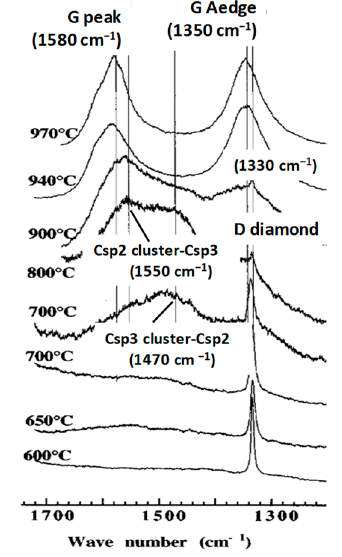
Figure 6. Diamond degradation with temperature by L. Fayette et al. [117] with permission of the Journal of Physical Review B. The D diamond peak decreases meanwhile Csp3-Csp2, G and G A edge peak are growing.